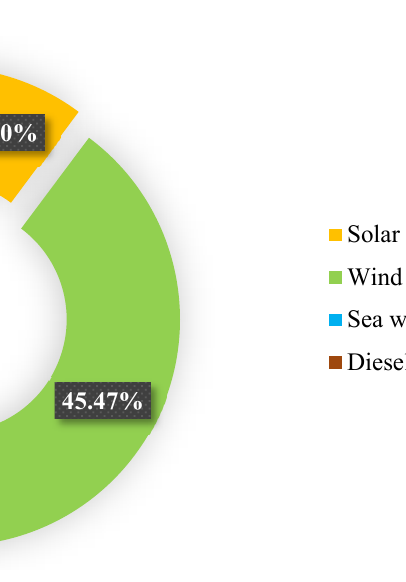
Figure 6. Total electrical production from RES in the Aeolian Islands.